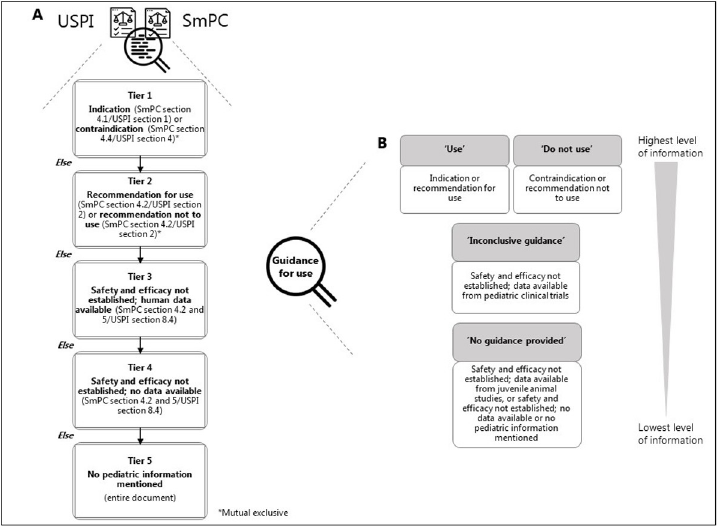
Fig 1. Categorization and hierarchical grouping of pediatric information. A) Tiered categorization of pediatric information in the SmPC and the USPI and B) hierarchical grouping of the categorized pediatric information to provide guidance for pediatric